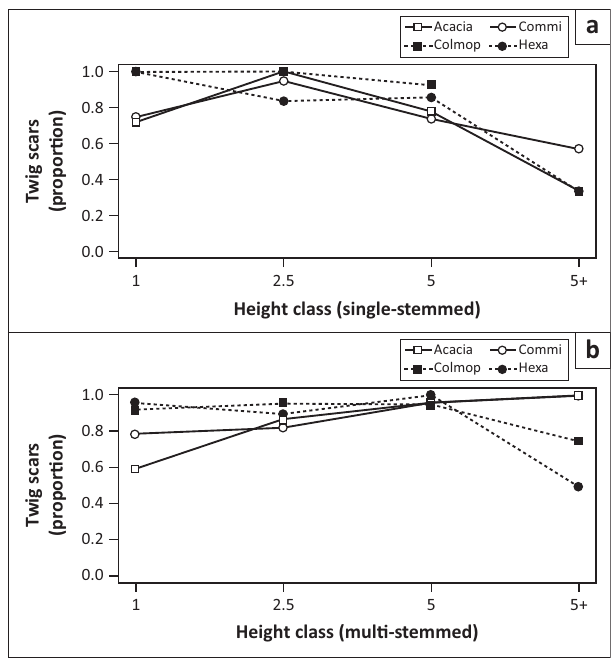
FIGURE 5: Proportion of plants with twigs browsed among vegetation types for (a) single-stemmed plants and (b) multi-stemmed plants.